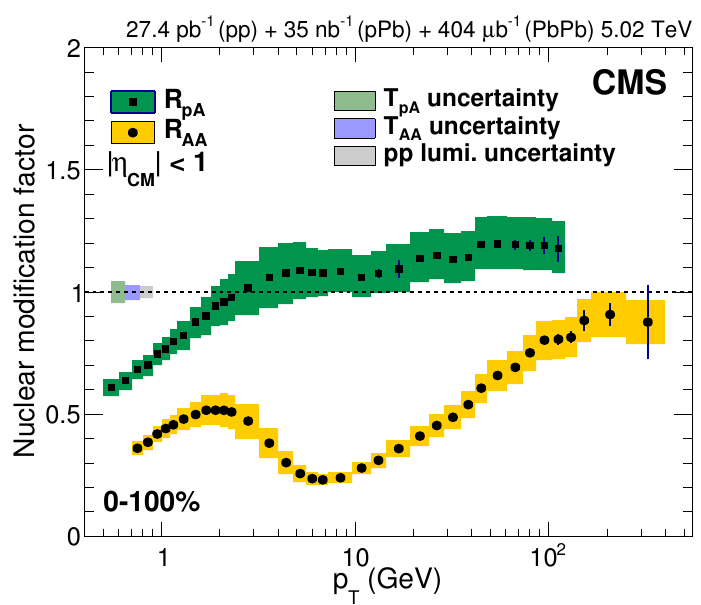
Figure 6 . Measurements of the nuclear modi(cid:12)cation factor for an inclusive centrality class for both PbPb and pPb collisions. The R pA values are formed using the previously published CMS pPb data [13] and the pp reference spectrum described in this paper. Please refer to the main text about the exact procedure followed. The green and yellow boxes show the systematic uncertainties for R pA and R AA , respectively, while the T pA , T AA , and pp luminosity uncertainties are shown as boxes at low p T around